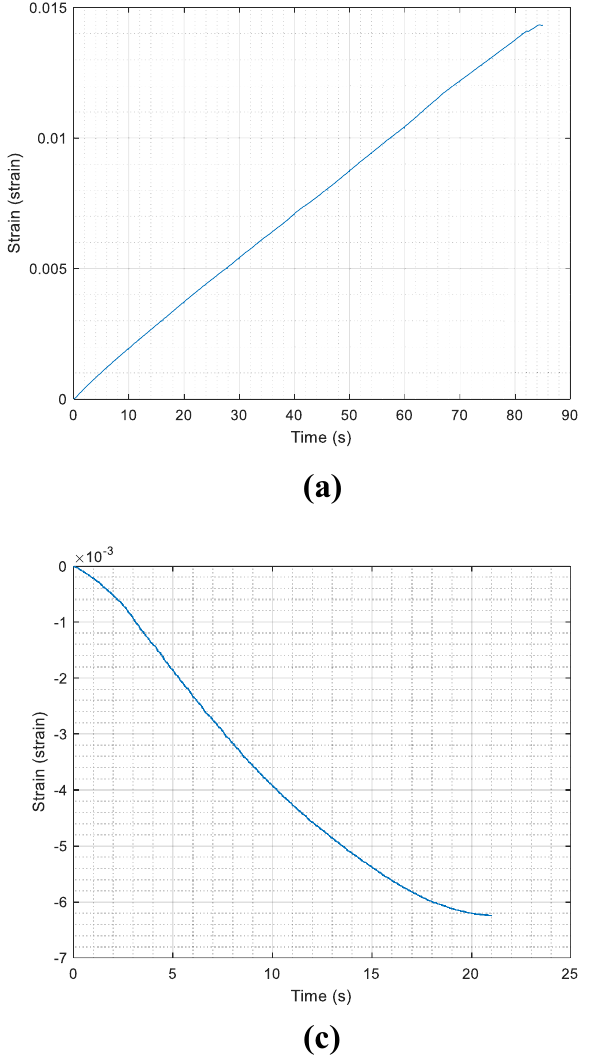
compression load applied to a GFRP sample with embedded gra- phene sensor c and d